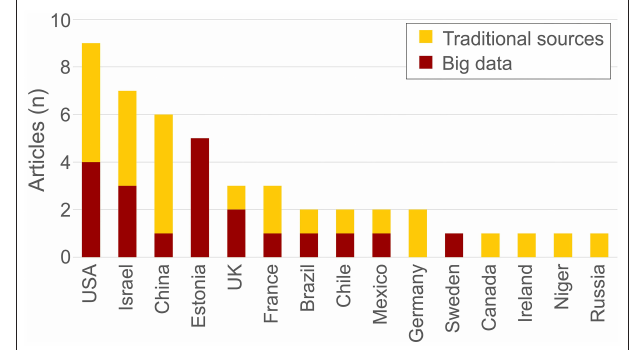
FIGURE 4 | Geographical distribution of the activity space segregation case studies ( n =